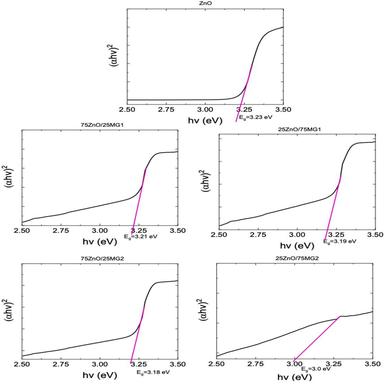
K-M function versus the energy of light given for the synthesized materials.